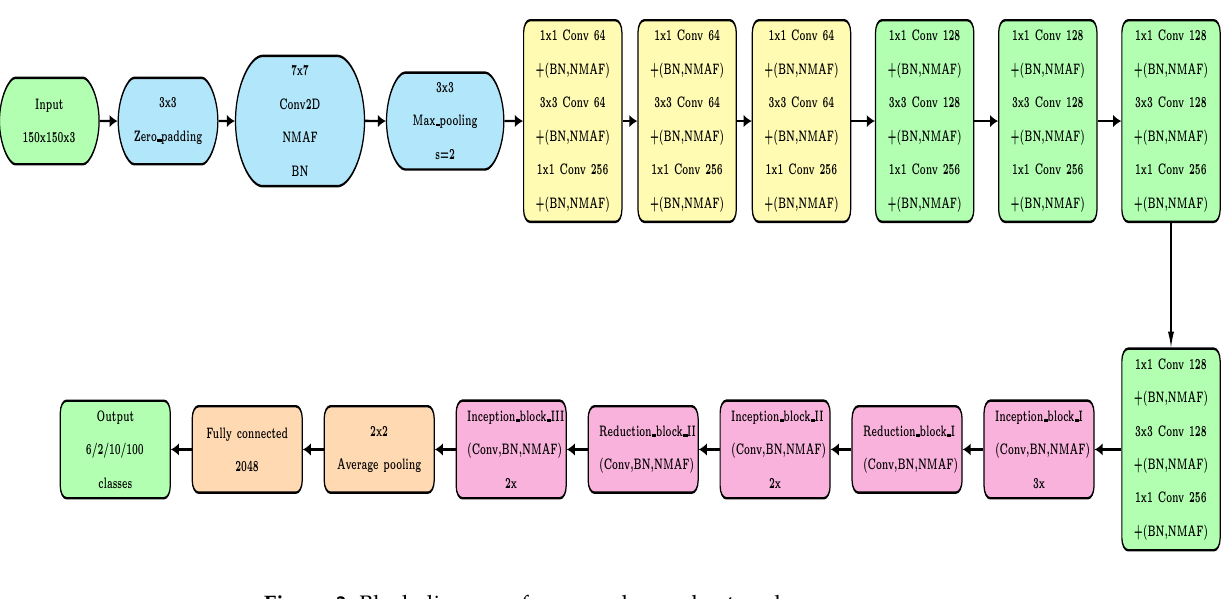
Figure 3. Block diagram of proposed neural